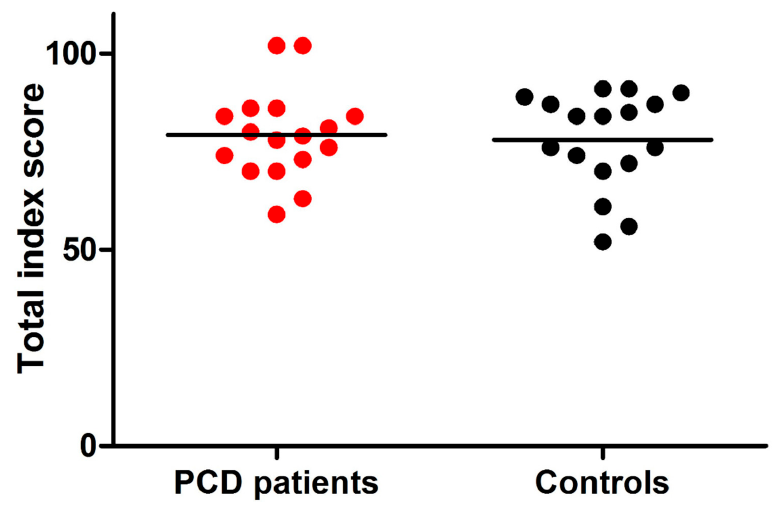
Figure 2. Distribution of PSGWBI total index score from PCD patients and controls. Legend: Psychological general well-being index (PSGWBI) questionnaire was administered in primary ciliary dyskinesia (PCD) patients (n = 17) and healthy controls (n = 17) ≥ 15 years. The PSGWBI is organized into subscales, the subscales sum provides a total index score for subjective well-being (range 0–110). Considering ‘distress’ as the reverse of well-being, a total score < 60 suggests ‘severe distress’, while the ‘moderate distress’ and ‘no distress’ categories are defined with a total score between 60 and 72, and > 72, respectively. Each point (red and black for PCD patients and controls, respectively) represents the total index score obtained by a single subject. Horizontal bars represent the mean values. The dashed line represents the total index score of 60. Only one PCD patient and two controls presented pathological scores. There were no significant differences of total index score between PCD patients and healthy controls ( p > 0.05).